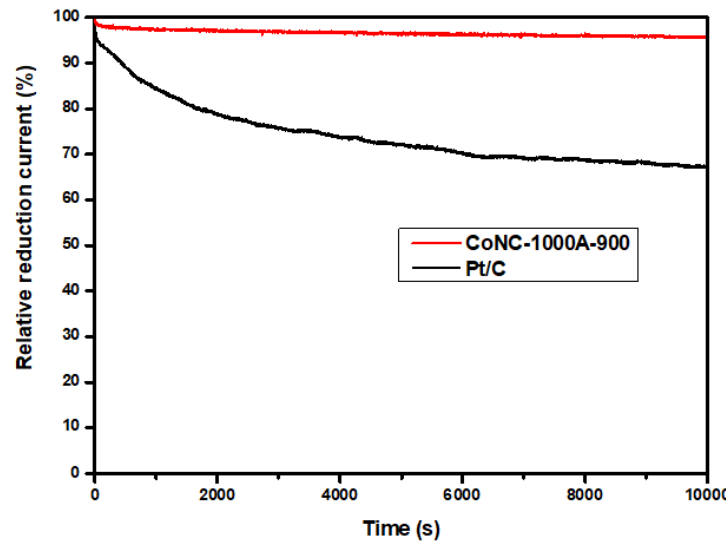
Figure 11. Durability test of CoNC-1000A-900 and Pt/C catalysts .